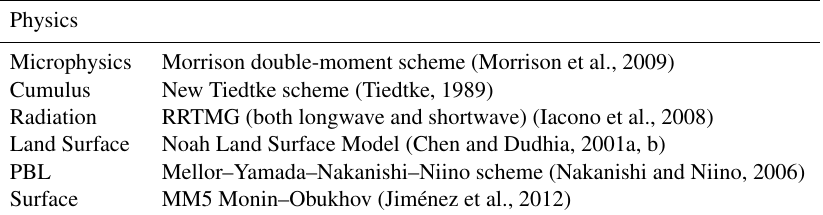
Table 1. Physical parameters.